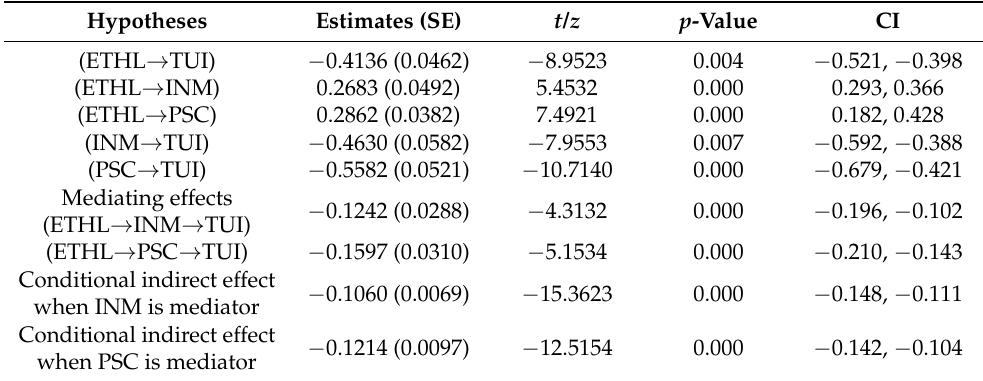
Table 6. Hypotheses